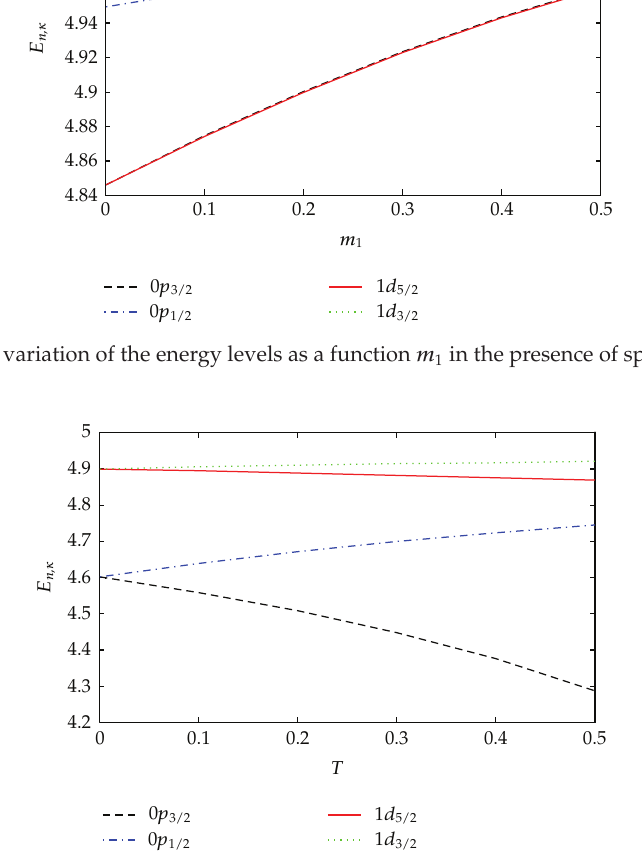
Figure 2: The variation of the energy levels as a function T in the presence of spin